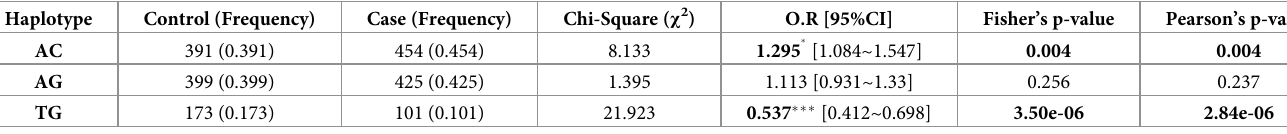
Table 4. Haplotype analysis (chosen loci rs708035 and rs3844283 ).